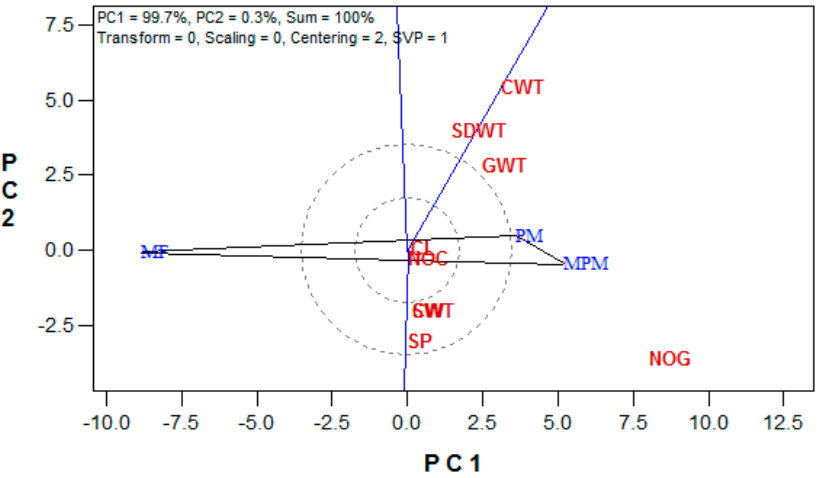
Figure 3. The which-won-where view of the GGE biplot for the soil amendment. (NOC = cob number, CL = cob length (cm), CW = cob width (mm), GCWT = cob weight (g plant − 1 ), GWT = grain weight (g plant − 1 ), NOG = grain number, SP = shelling percentage (%), SWT = 100-seed weight (g plant − 1 ), and SDWT = stover dry weight (g plant − 1 )).